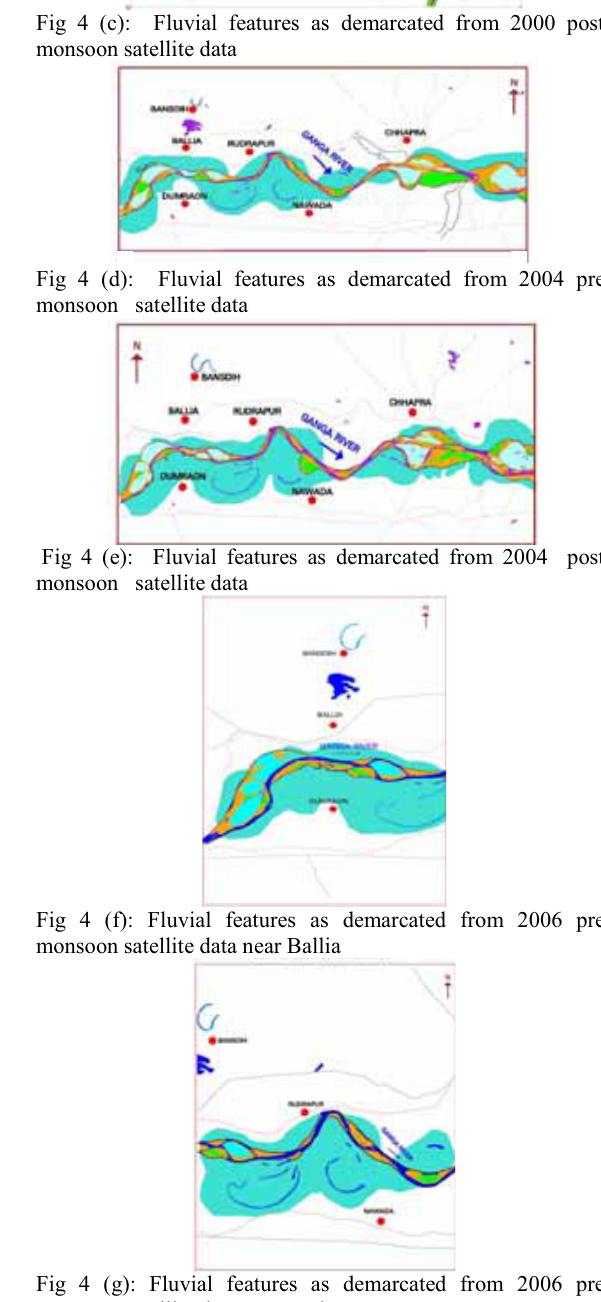
Fig 4 (b): Fluvial features as demarcated from 2000 pre- monsoon satellite data